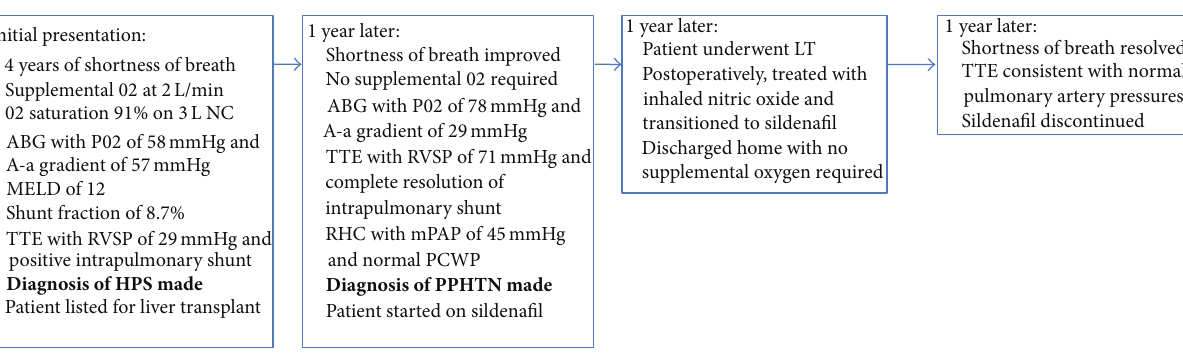
Figure 2: Sequence of events for Case